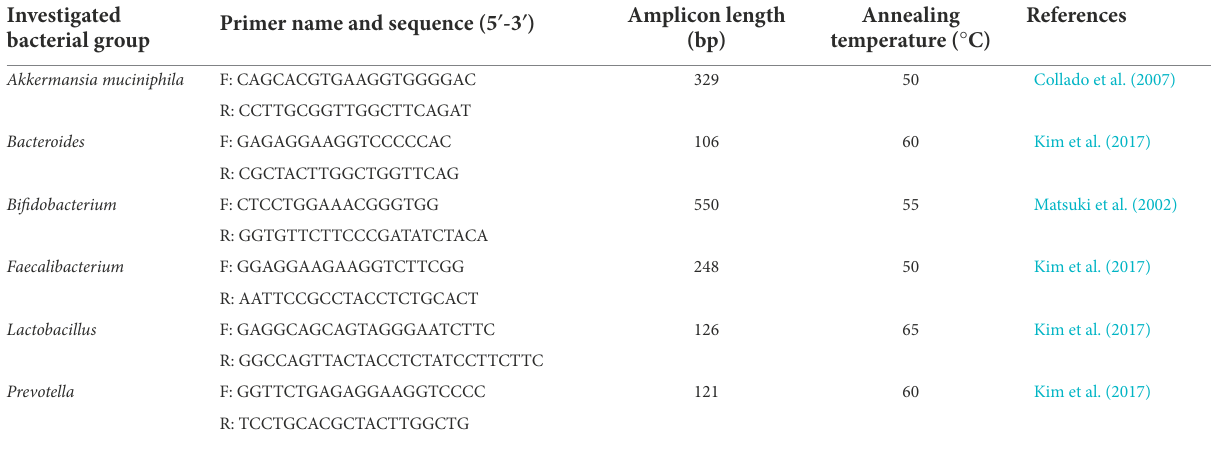
TABLE 2 Primer pairs used in this study for the quantification of microbial genera and Akkermansia muciniphila . Investigated bacterial